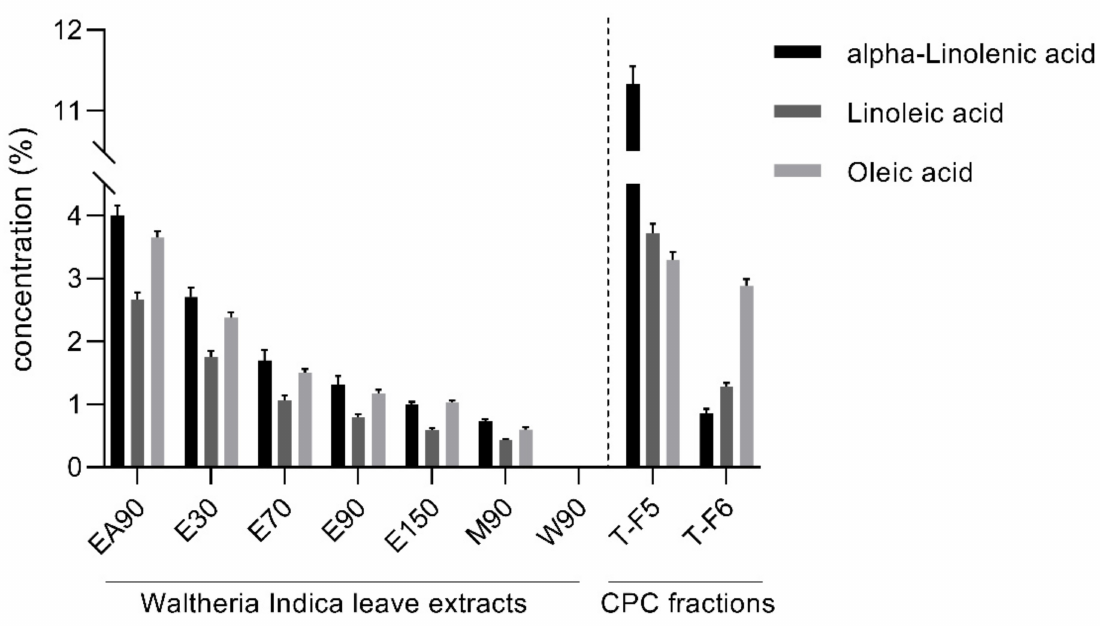
Figure 5. Concentration (%, w / w ) of alpha-linolenic acid, linoleic acid and oleic acid in dried Waltheria indica leaf extracts obtained by varying extraction temperatures and solvents (left of dashed line) as well as CPC fractions T-F5 and T-F6 obtained from extract E70 (right of dashed line). Data points represent the mean value ± standard deviations of three